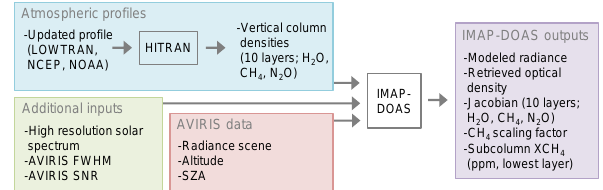
Fig. 3. Processing steps for IMAP-DOAS CH 4